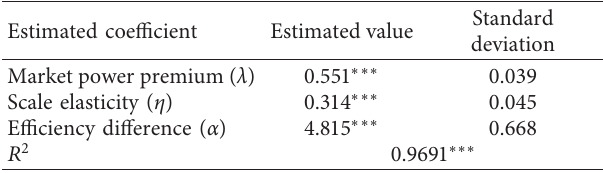
Table 2: The estimation results of 2SLS model. Estimated coefficient